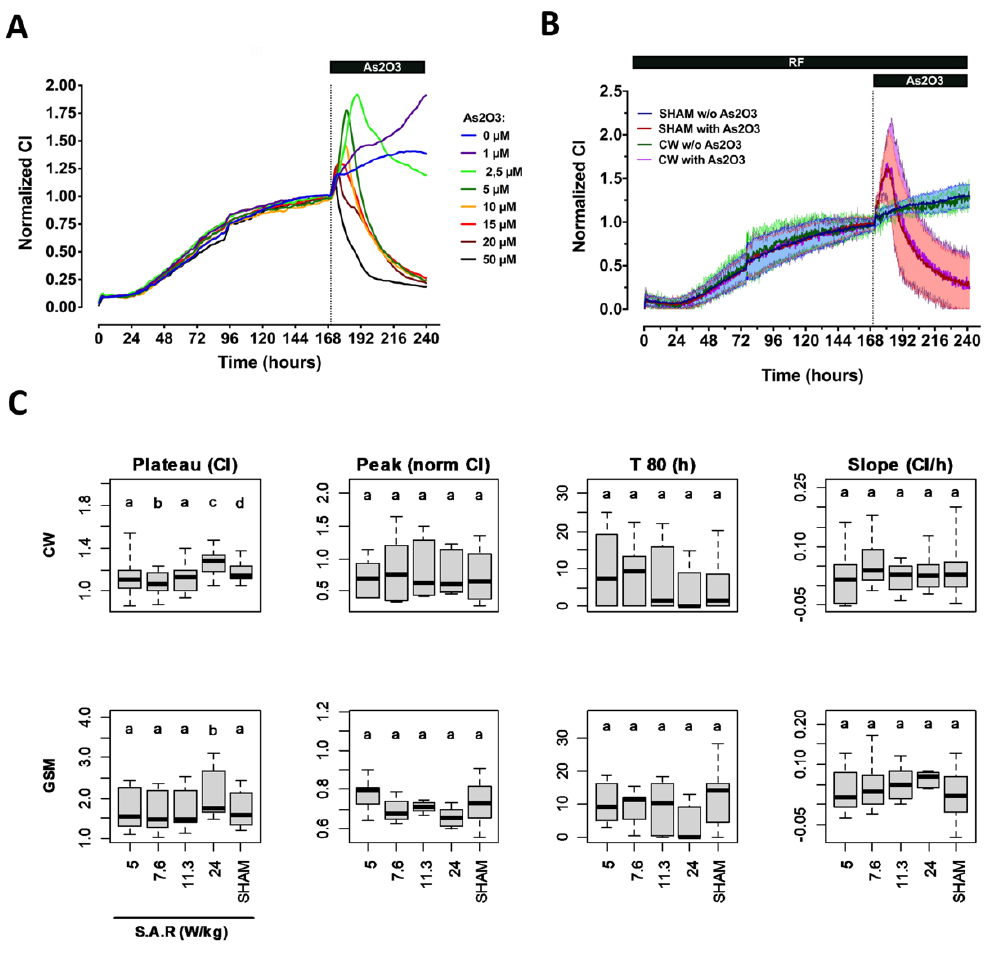
Figure 3. Characterization of the response of primary cortical cells co-culture under RF exposure alone or co-exposure to RF and As 2 O 3 . ( A ) Characterization of the CI temporal signature of primary cortical cells co-culture challenged with increasing concentrations of As 2 O 3 . The vertical dashed line indicates the time at which cells were either mock-challenged or challenged with the indicated concentration of As 2 O 3 . The data represent the average of three independent experiments. For better clarity, the measurement error is not represented. ( B ) Example of the normalized CI temporal signature recorded from primary cortical cells co-culture that were either sham-exposed or exposed to unmodulated 1800 MHz (CW signal) at 24 W/kg. The vertical dashed line indicates when cells were either mock-challenged or challenged with 5 µM As 2 O 3 . The data represent the average of 5 to 6 independent experiments ± SEM values. ( C ) Statistical analysis of the effect of CW or GSM-modulated 1800 MHz signals emitted at 5, 7.6, 11.3, or 24 W/kg on four metrics describing primary cortical cells co-culture impedance measurement in absence or presence of As 2 O 3 . First left column: average CI measured during the 5 h preceding injection of As 2 O 3 or buffer. Second column to the left: magnitude of the CI increase in response to As 2 O 3 . Third column to the left: time at which 80% of the cell population died following As 2 O 3 injection. Last column on the right: Cell proliferation rate during the last day of the experiment in the absence of As 2 O 3 . The number of replicates per condition is indicated in Supplementary Table S1.